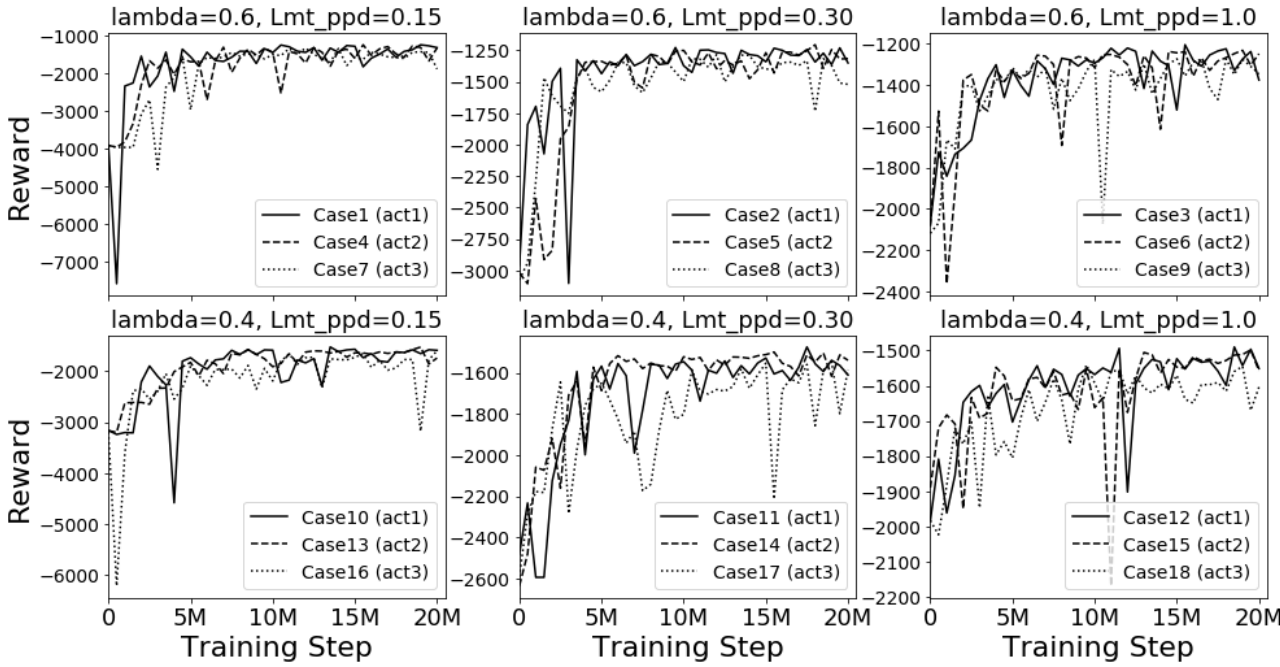
Figure 5. The history of one simulation period’s cumulative reward for all cases in the training.